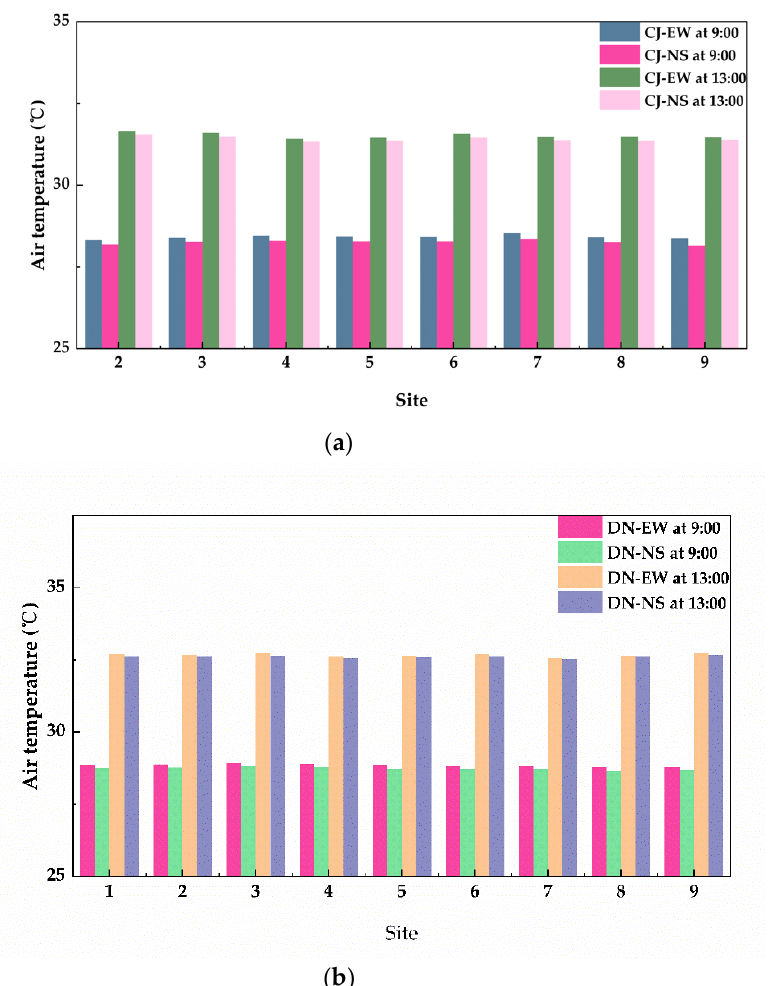
Figure 5. Comparison of the air temperature between W-E road and S-N road at 1.5 m from the ground at 9:00 (morning) and 13:00 (afternoon) on 21 July 2018, ( a ) CJ village, ( b ) DN village.